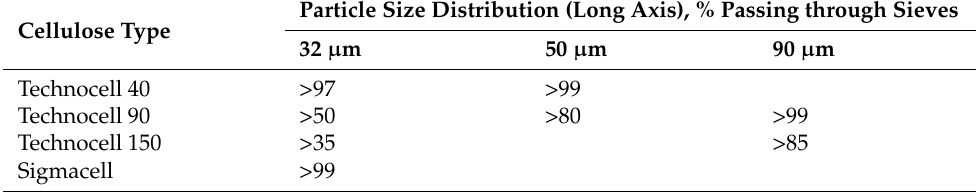
Table 2. Particle size distribution of cellulose fibers (provided by the manufacturers). Cellulose